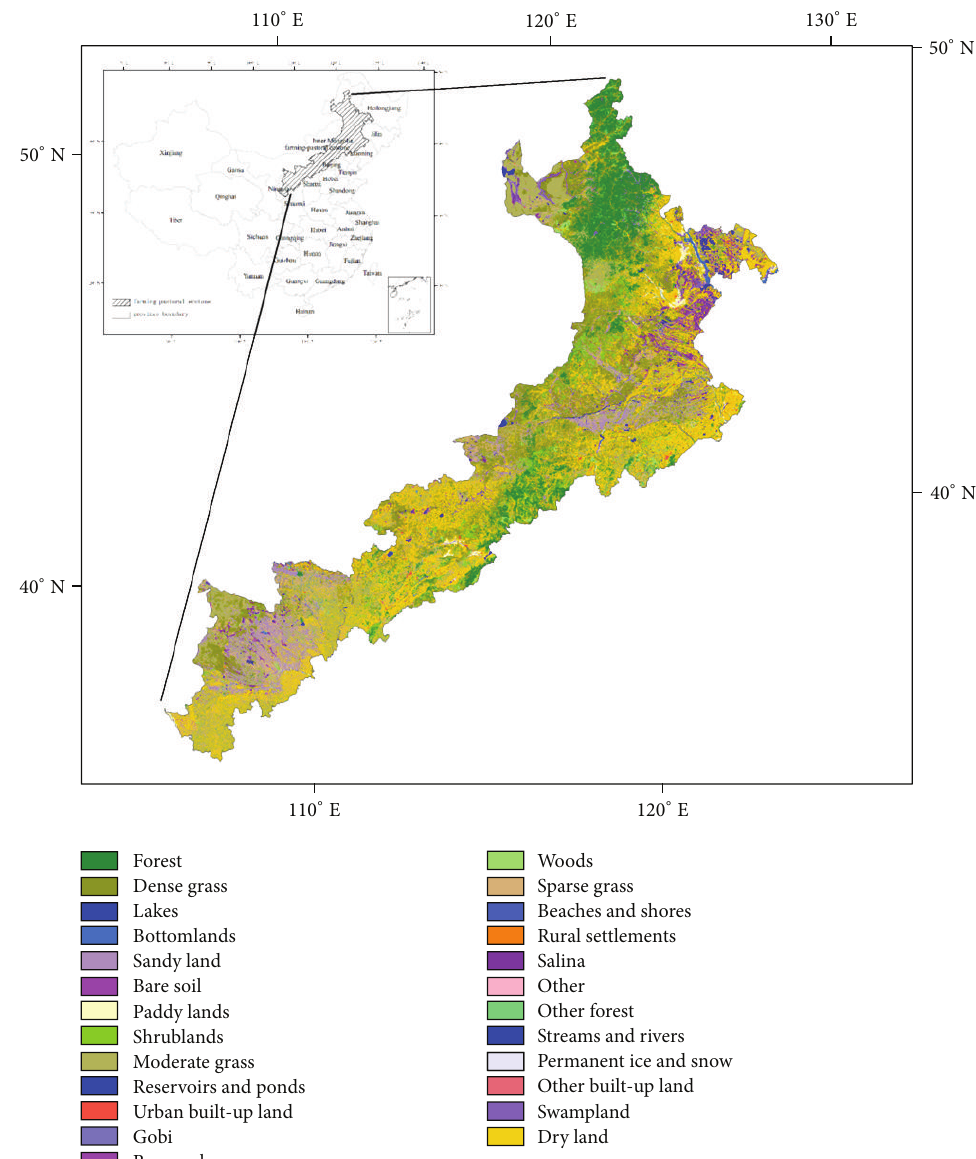
Figure 1: The location and 2000 years’ land use map of farming-pastoral ecotone in North